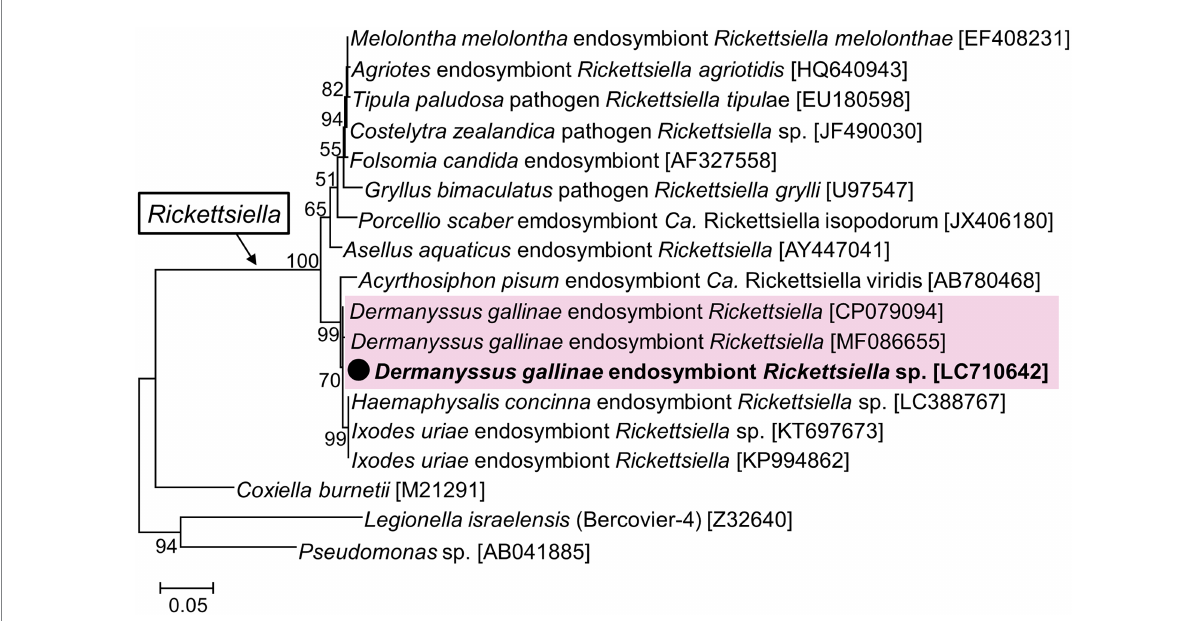
FIGURE 5 Phylogenetic relationship of the 16S rRNA sequences of Rickettsiella and related species. A maximum-likelihood phylogeny (model HKY + G + I) inferred from 1,018 aligned nucleotide sites is shown with bootstrap probability at each node. The sequences in bold with black circle are those obtained in this study. OTU of Rickettsiella from D. gallinae are shaded in pink. Numbers in square brackets indicate NCBI accession